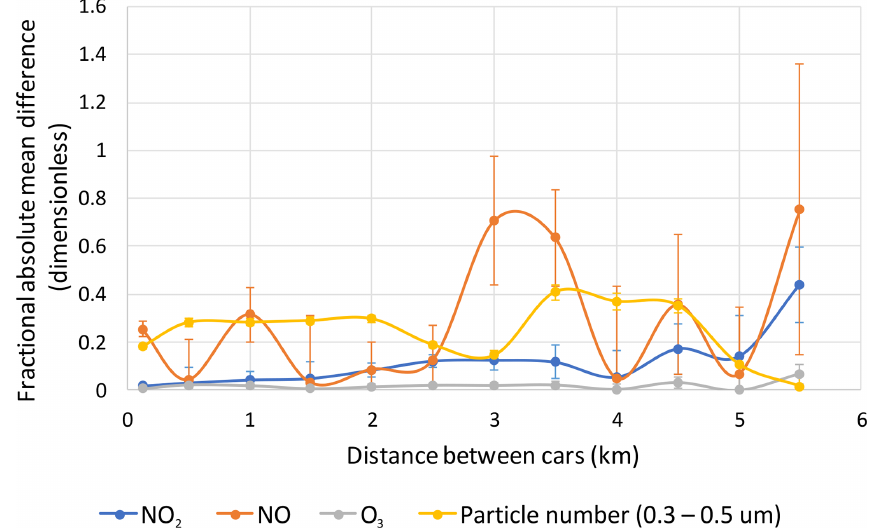
Figure 3. Intervehicle FAMD vs mean intervehicle distance associated with sampling in Los Angeles (near CELA) from 3 to 12 August, averaged over 0.5km bins (0–0.25km, 0.25–0.75km, etc.). Error bars are 1 σ uncertainties determined as described in the definition of FAMD. The sizes of the error bars reflect variations in the number of samples in each bin ( N = 14 to 2433) as well as sampling variability.